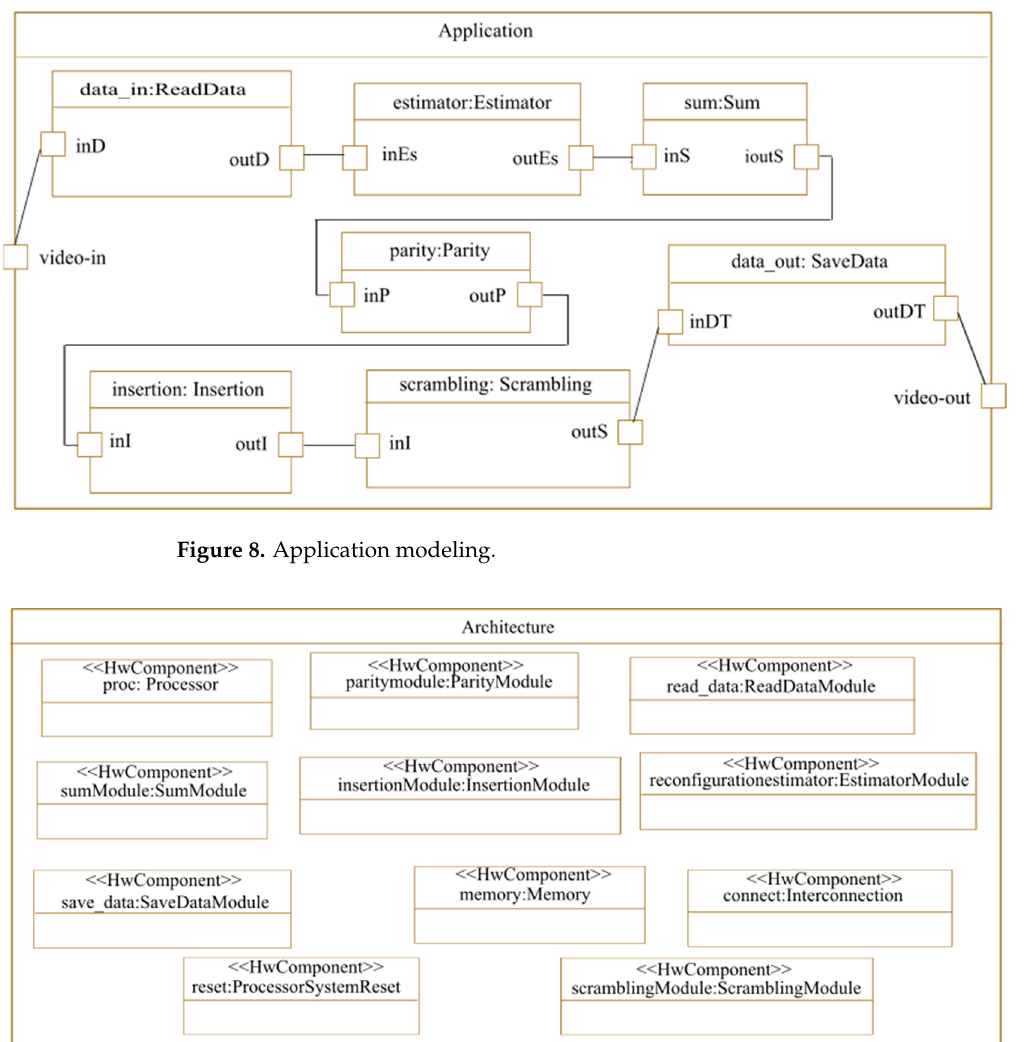
Figure 10. Estimator